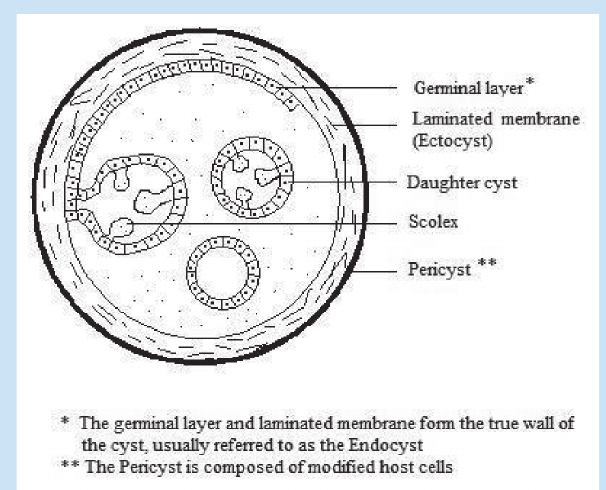
Fig. 6. Histological diagram of a hydatid cyst.